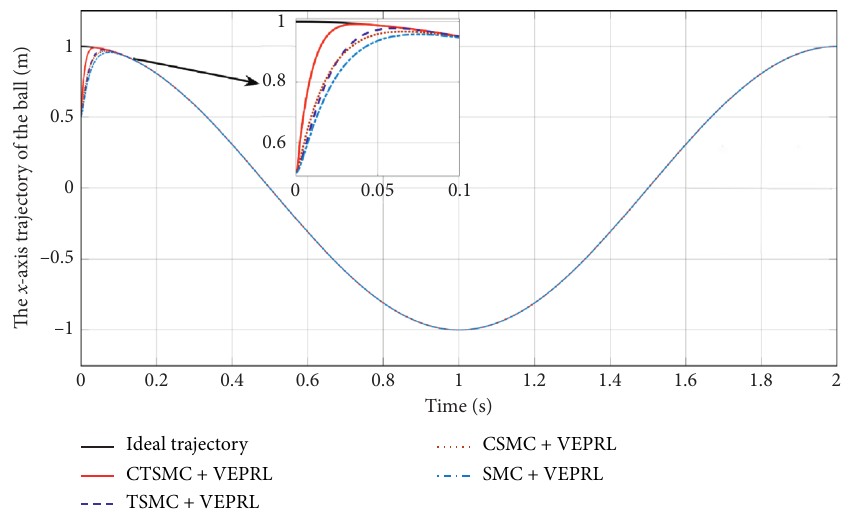
Figure 11: Comparison of x -axis tracking trajectory of the ball and plate system under VEPRL.